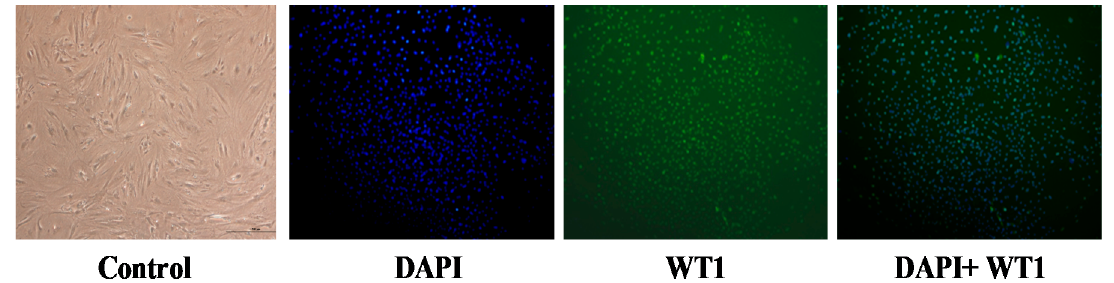
Figure 4. The primary sertoli cells separated from testicle tissue (Confocal). DAPI (4 ′ ,6-diamidino-2-phenylindole) stands for staining of cell nucleus, WT1 stands for staining of the special marker Wilms Tumor staining of the sertoli cells, DAPI+WT1 stands for merged registration of two stainings of the cell nucleus. The photograghs were 200 times captured.